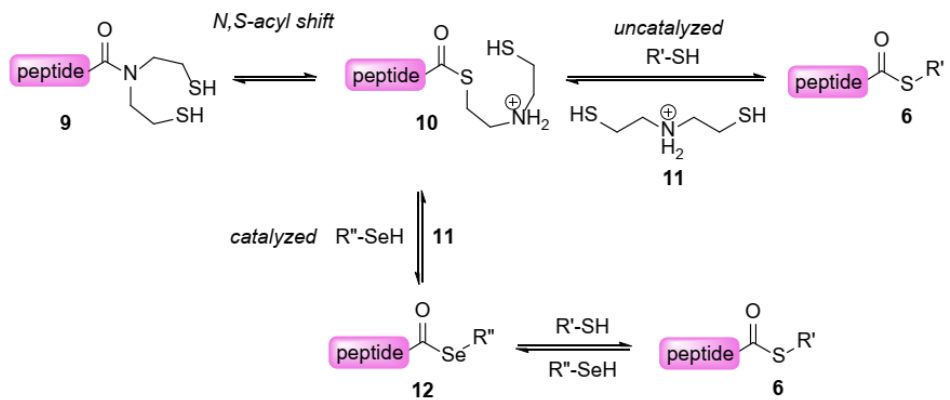
Figure 2. Mechanism of the SEA/thiol exchange catalysis by selenols.